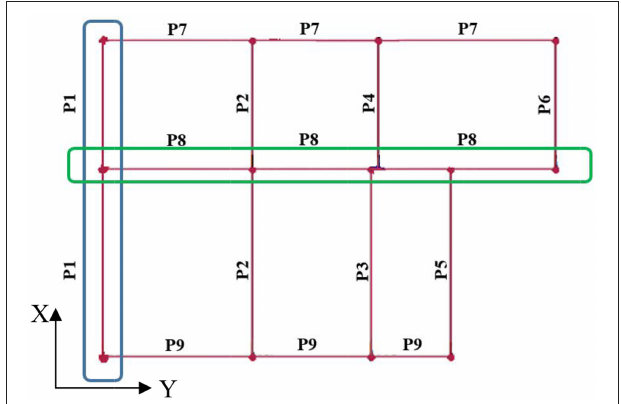
FIGURE 2 | Layout and numbering of masonry walls in the 3Muri